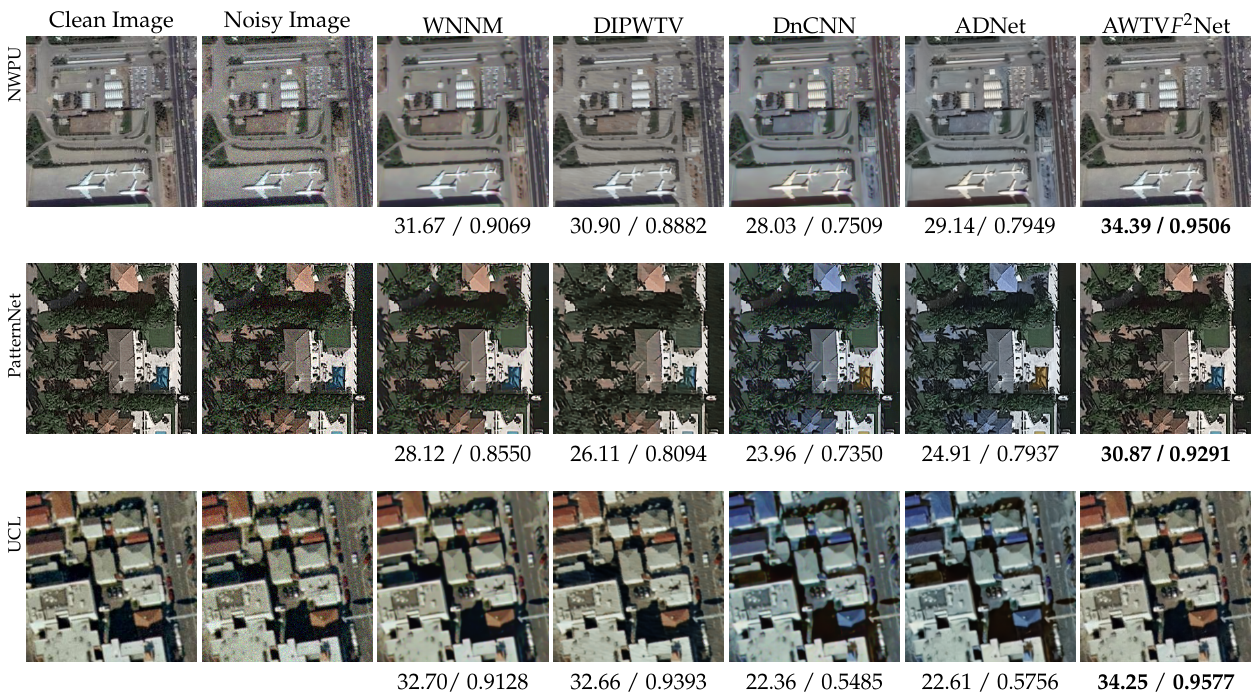
Figure 8. Restored images of NWPU, PatternNet and UCL datasets with noise level σ 2 =